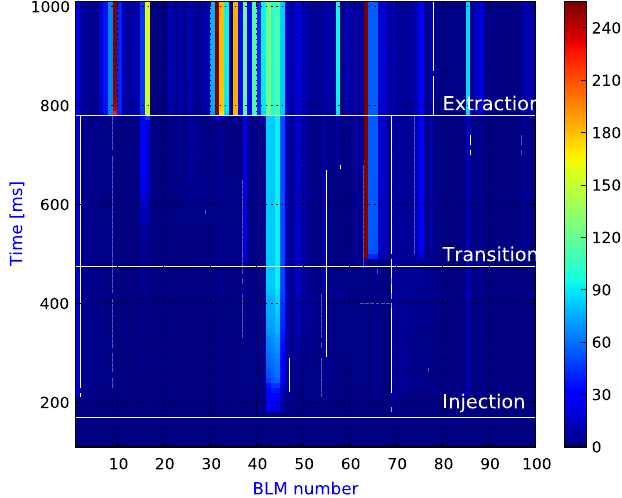
FIG. 3. BLMs integrated measurement for the CNGS beam.